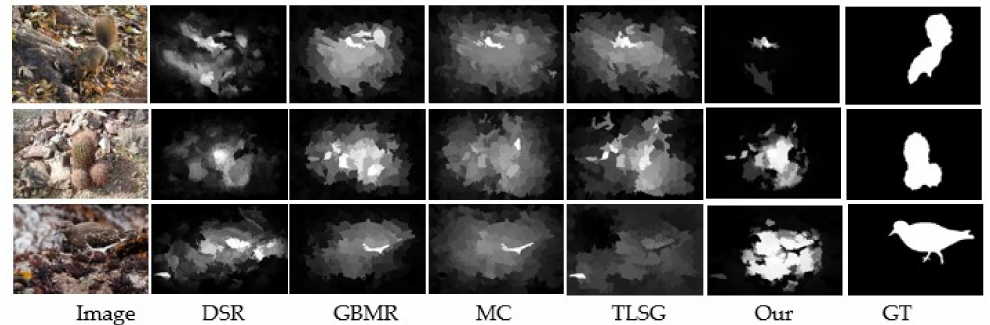
Figure 17. Failure cases of our method and some diffusion-based